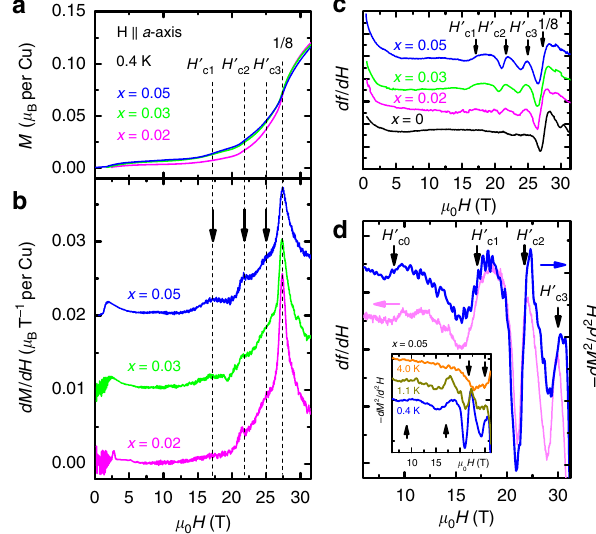
Fig. 3 Emergence of magnetization anomalies below the 1/8 plateau. Field dependence of a , M and b , dM / dH , for three doping levels x = 0.02 (magenta), 0.03 (green), and 0.05 (blue), with H ∥ a -axis, at T = 0.4 K. The feature corresponding to the pseudo-1/8 plateau is marked by a dashed line at ~27 T. H ’ C1 , H ’ C2 , and H ’ C3 and the corresponding dashed lines indicate three of the additional anomalies below the pseudo-1/8 plateau. For clarity, a shift of 0.01 (0.02) µ B T -1 per Cu is added to the x = 0.03 (0.05) trace. c The fi rst derivative of the frequency shift, df / dH ( ∝ dM 2 / d 2 H ), as a function of applied fi eld for x = 0 (black), 0.02 (magenta), 0.03 (green), and 0.05 (blue), measured by the tunnel diode oscillator technique (see “ Methods ” ) at the dc fi eld facility of NHMFL. Upon doping, three anomalies emerge at H ’ C1 , H ’ C2 , and H ’ C3 , consistent with the magnetization measurements in ( b ). d A zoomed-in plot of df / dH (light magenta, left axis) and − dM 2 / d 2 H (blue, right axis) vs. µ 0 H for the x = 0.05 sample, shows an additional broad anomaly at a lower fi eld H ’ C0 . Inset: − dM 2 / d 2 H vs. µ 0 H for a few selective temperatures. The arrows, from left to right, indicate H ’ C0 , H ’ H ’ H ’ C1 , C2 , and C3 , respectively. Traces in ( c ) and inset of ( d ) are shifted for